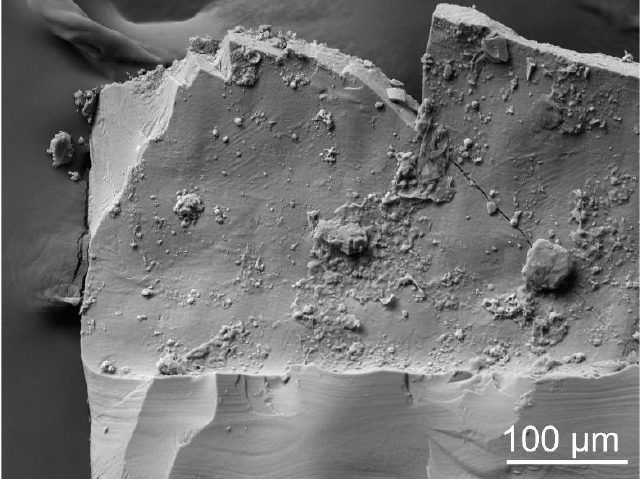
Figure 2. Microlamellar fabric in Holoconularia from the Carboniferous of Russia.